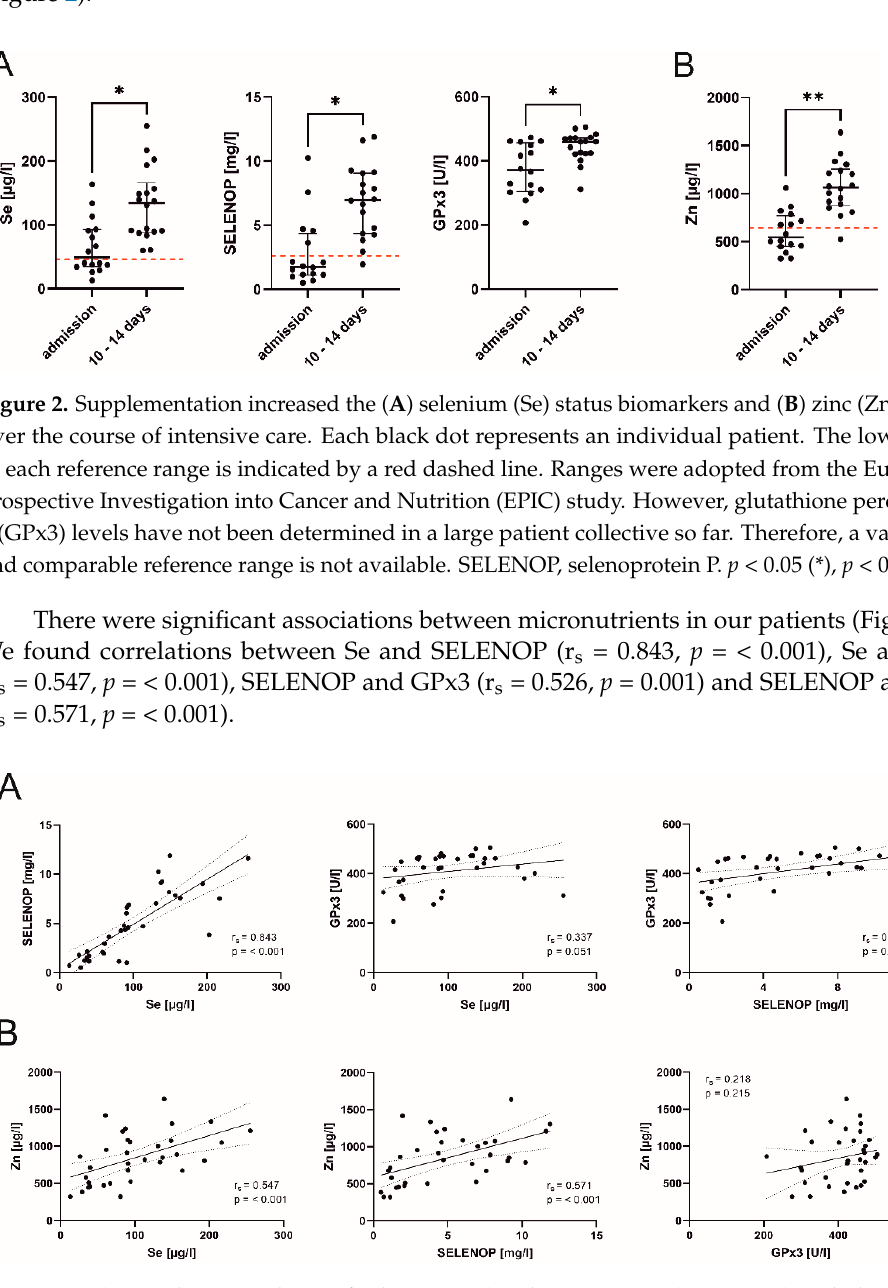
Figure 3. ( A ) Correlation analyses of selenium (Se), selenoprotein P (SELENOP) and glutathione peroxidase 3 (GPx3). ( B ) Correlation of Se status biomarkers and zinc (Zn). Spearman’s correlation coefficients (r s ) and respective p -values are indicated. Linear regression was applied and the 95% confidence interval is shown.